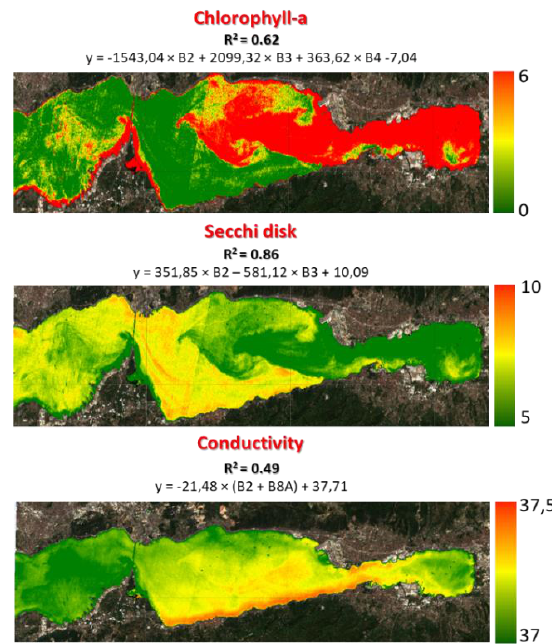
Figure 7. The spatial distribution patterns of three selected water quality parameters produced by the best regression models